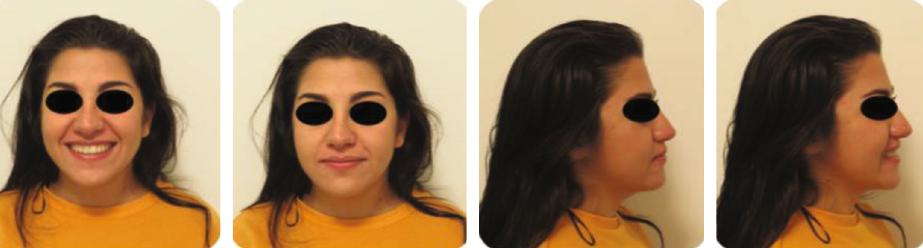
Figure 5: Posttreatment extraoral